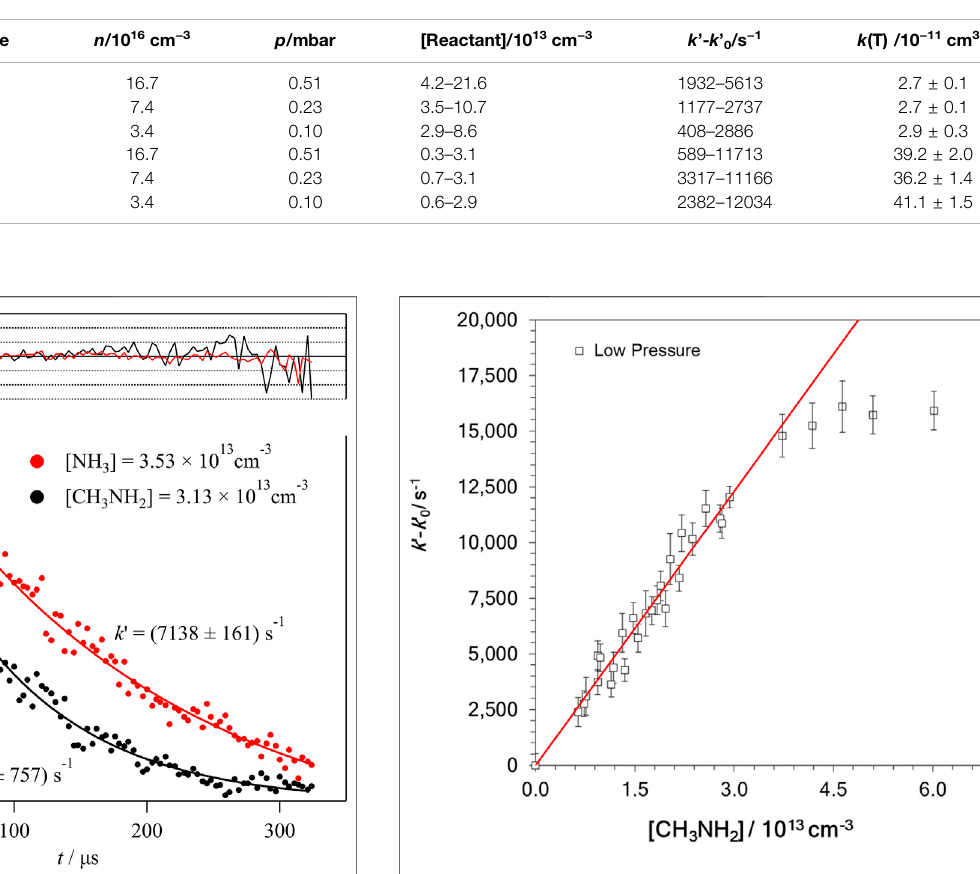
FIGURE 2 | Example of the observed curvature in the bimolecular plots for the OH + CH 3 NH 2 reaction at ca. 22 K and 3.4 × 10 16 cm − 3 . Solid line represents k 2 obtained from the fi t of all data from Figure 3